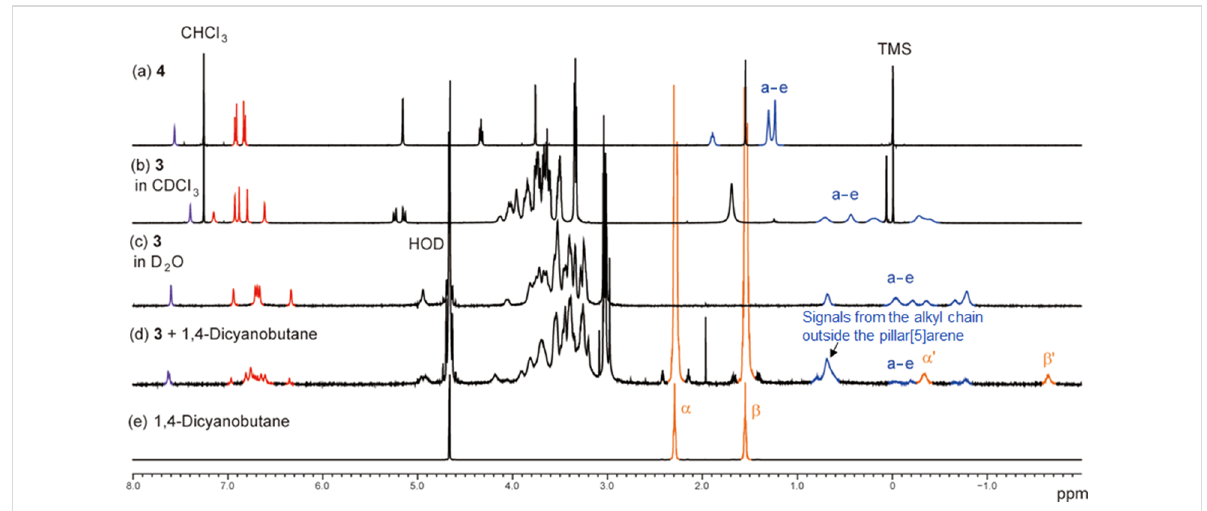
Figure 2: 1 H NMR spectra of (a) model compound 4 (2 mM at 25 °C in CDCl 3 ), (b) 3 (2 mM at 25 °C in CDCl 3 ), (c) 3 (2 mM at 10 °C in D 2 O), (d) 3 (2 mM) and 1,4-dicyanobutane (20 mM) at 10 °C in D 2 O and (e) 1,4-dicyanobutane (20 mM at 10 °C in D 2 O). Resonances are labeled as shown in Figure